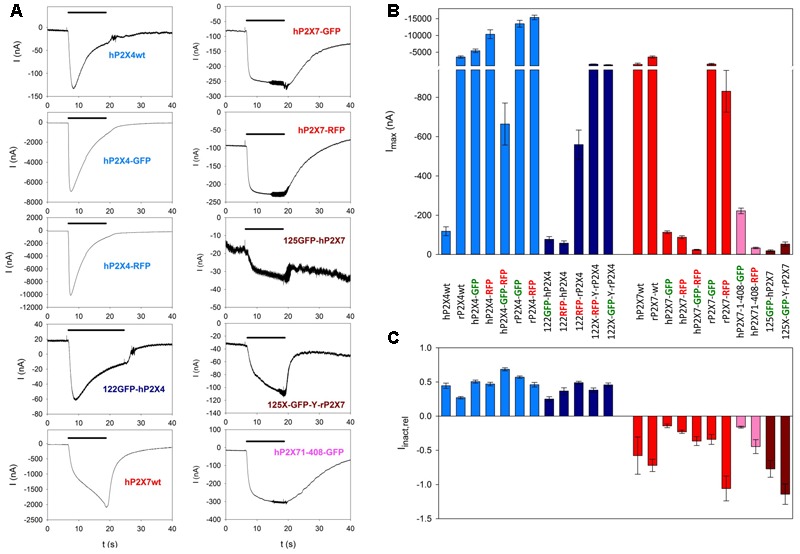
Functional testing of fluorescence-labeled P2X4 and P2X7 constructs by two-electrode voltage clamp measurements. (A) Examples of current traces in oocytes expressing wildtype P2X4 (P2X4wt) of P2X7 (P2X7wt) or different fluorescence-labeled P2X4 and P2X7 constructs, as indicated. The colors of the construct names relate to the colors of the bars in (B,C). (B) Maximal current amplitudes obtained during the application of 1 mM ATP for 6 s. (C) Kinetics of ion channel currents in oocytes expressing different labeled P2X constructs. The relative inactivation (Iinact,rel) was calculated as the amplitude of the current between 2 and 6 s after the application of 1 mM ATP normalized to the current amplitude at the 2 s time point. A decay in the current amplitude (Iinact,rel > 0) indicates desensitization (seen for all P2X4 constructs); an increase in current amplitude during this period (Iinact,rel < 0) was usually seen for P2X7 constructs and is of unknown origin. Bar colors: light blue = P2X4wt or C-terminally labeled constructs, dark blue = P2X4 constructs labeled within the extracelllar domain, red = P2X7wt or C-terminally labeled constructs, rosy = C-terminally truncated and labeled P2X7 constructs, dark red = P2X7 constructs labeled within the extracelllar domain. Data are the means ± SEM from 5–20 oocytes.